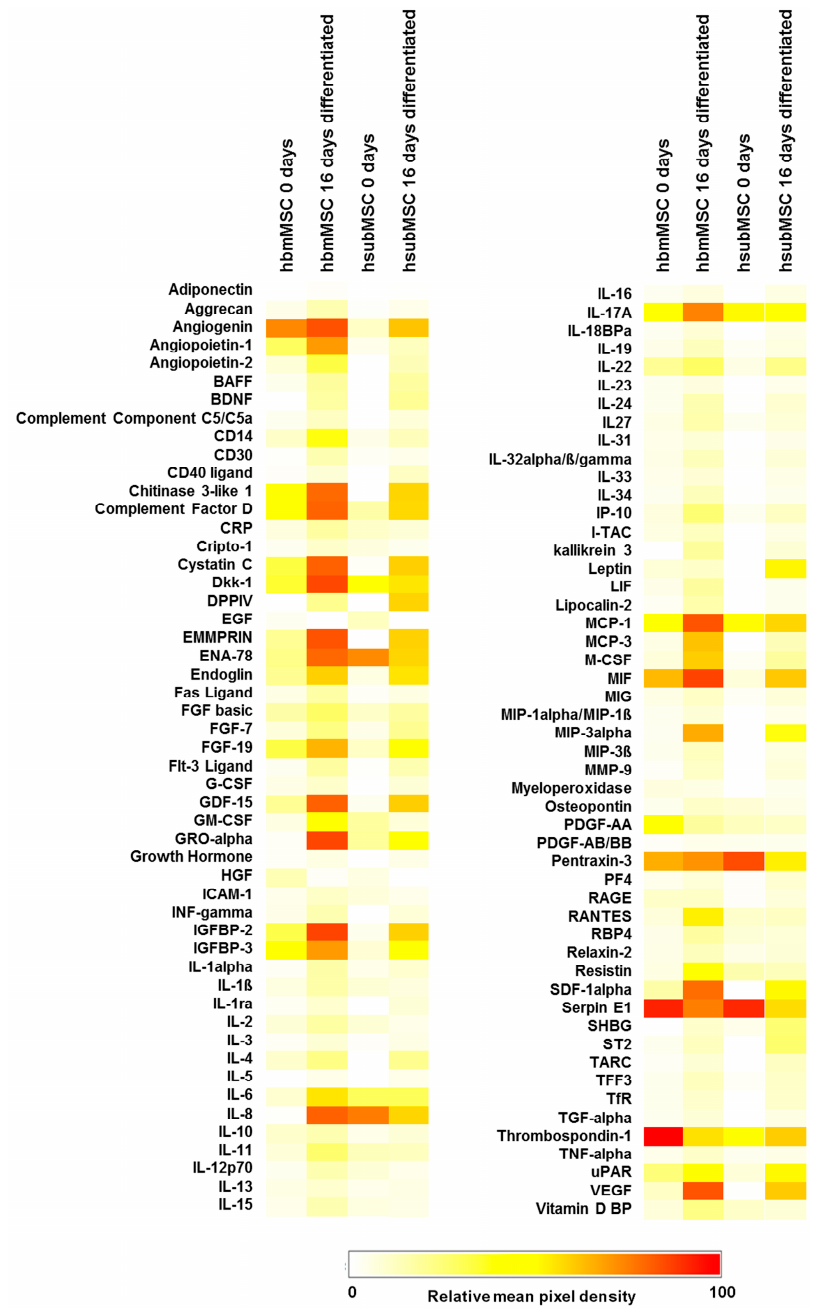
Figure 2. Heatmap of secretory protein abundance of undifferentiated (0 day) and differentiated (16 day) hbmMSC and hsubMSC. The heatmap was created by setting the maximal pixel intensity of the reference spots on the array arbitrarily to 100 (red colour), to which the abundance of all other analytes is relative. Minimal abundance (0) is encoded by white, mean abundance (50) by yellow colouring. Pixel densities shown were calculated as means from three independent experiments with MSC from different donors each.